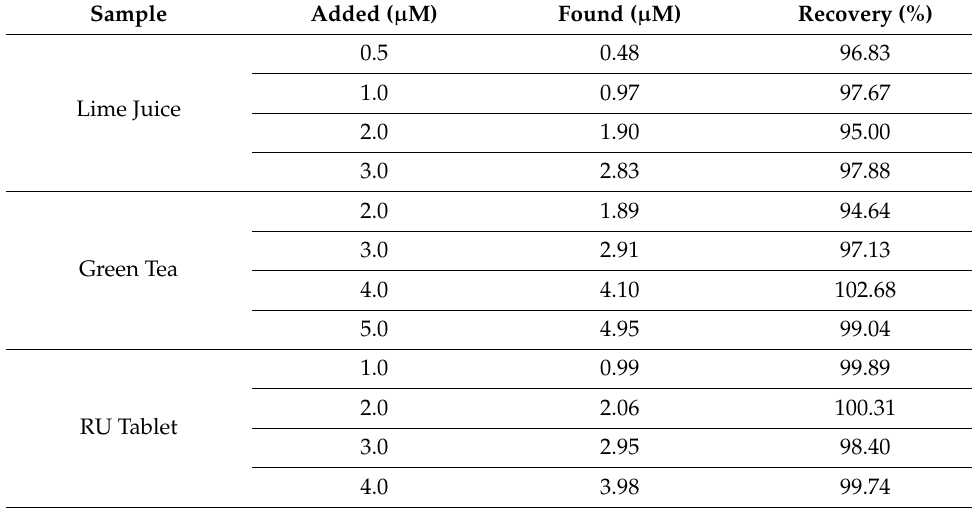
Table 2. Recovery of RU in